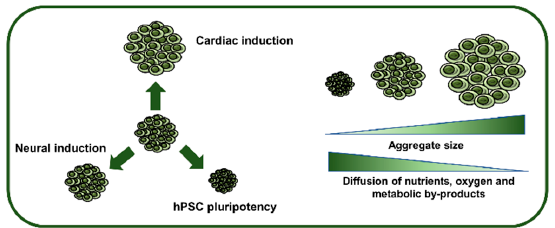
Figure 2. Influence of hPSC aggregate size on pluripotency maintenance, lineage specification and inner diffusion rates. The initial diameter of hPSC aggregates will determine the efficiency of induction into a specific lineage, as well as influencing the expansion capability. Furthermore, as aggregates increase in size, they are subjected to diffusional limitations that may cause necrotic zones in the inner part of the aggregates.